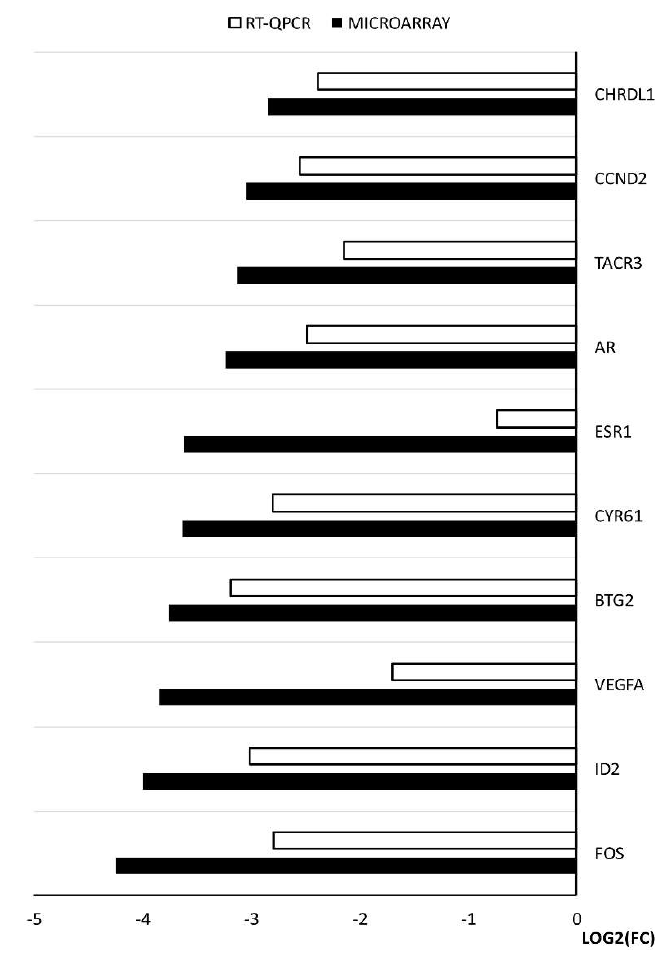
Figure 7. The results of RT-qPCR validation of the microarray analysis, presented in a form of a